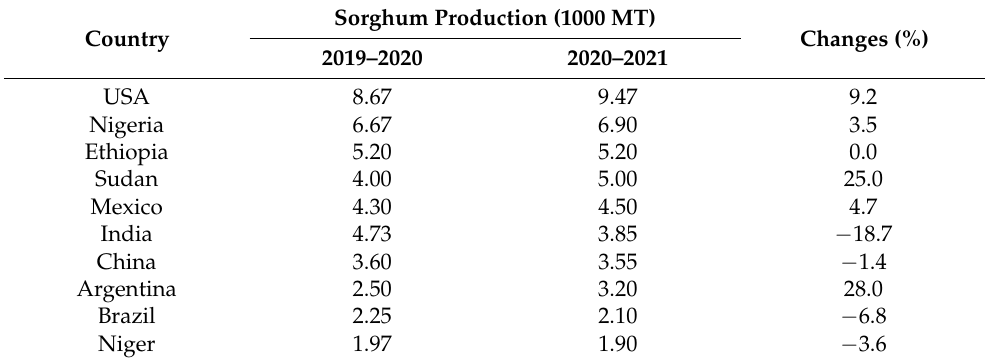
Table 3. Production of sorghum and changers percentage during 2019 to 2021 in different countries.